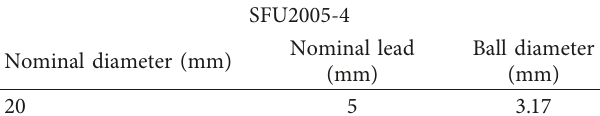
Figure 5: The designed experiment platform.1: motor; 2: couple; 3: support bearing; 4: support bearing; 5: motion platform; 6: guide rail; 7: screw; 8: ball nut; 9: guide rail; 10: accelerometer; 11: ac- celerometer; 12: accelerometer. Table 1: Parameters of the test ball screw.